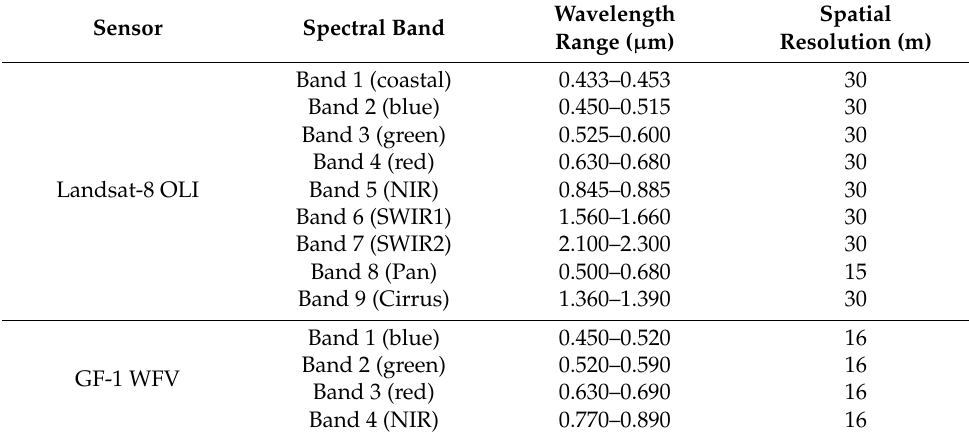
Table 1. The detailed information of Landsat-8 OLI and GF1-WFV multispectral images. Wavelength Spatial Sensor Spectral Band Range ( µ m) Resolution (m) Band 1